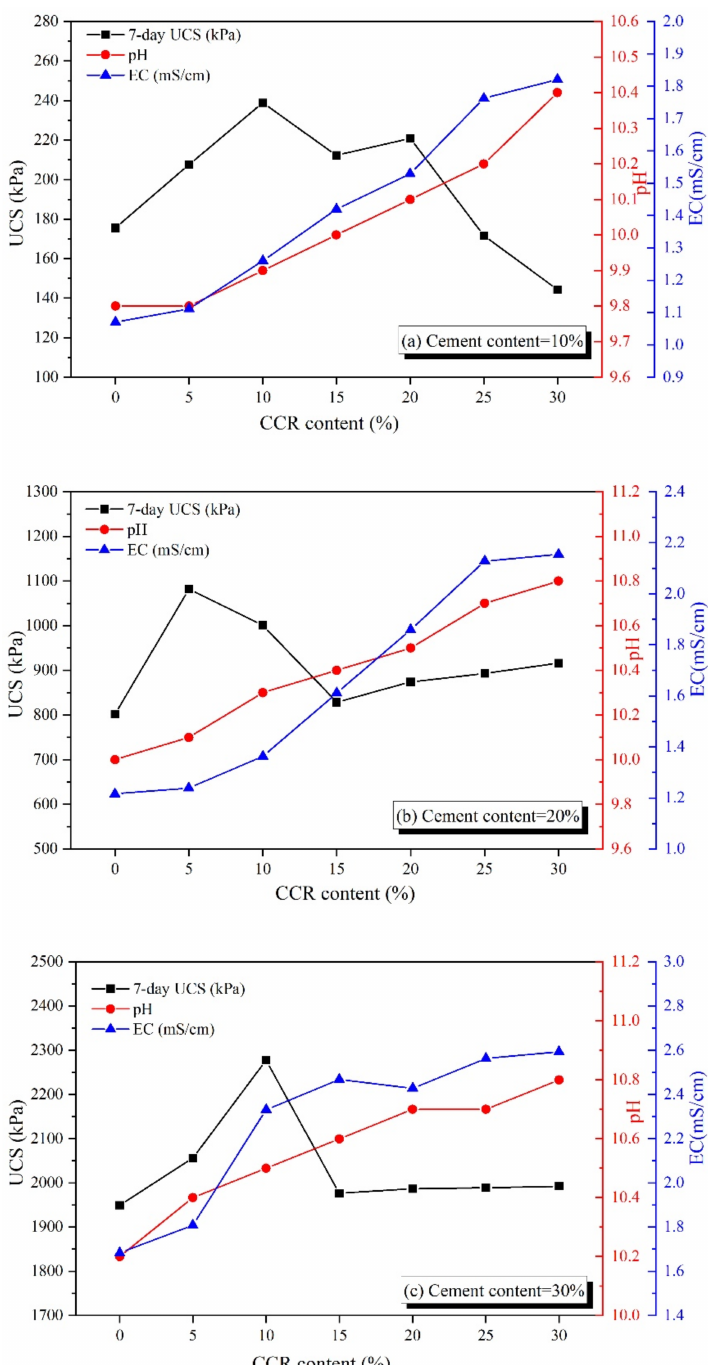
Figure 11. Relationships between CCR content and UCS, pH and EC of CPDS cured for 7 days with ( a ) cement content = 10%, ( b ) cement content = 20% and ( c ) cement content =